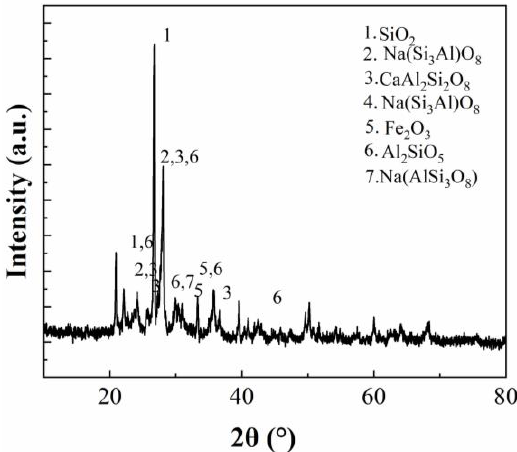
Figure 23. XRD analysis of MGS recycled brick.